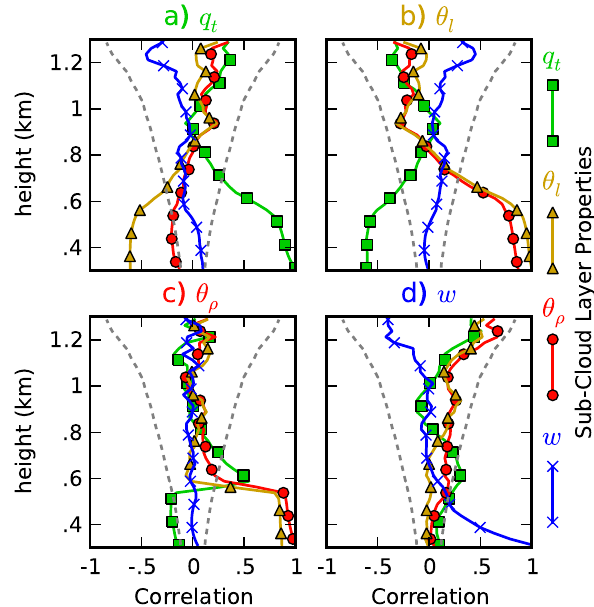
Fig. 11. Correlation profiles between cloud plume properties near the middle of the sub-cloud layer at 300m height and at higher lev- els for (a) total specific water q t , (b) liquid-water potential temper- ature θ l , (c) density potential temperature θ ρ , and (d) vertical veloc- ity w . Green squares show correlations with 300m level q t , yellow triangles correlations with 300m θ l , red circles correlations with 300m θ ρ , and blue x markers correlations with 300m w . Dotted lines show the 99% confidence level for a correlation to be signifi- cantly different than